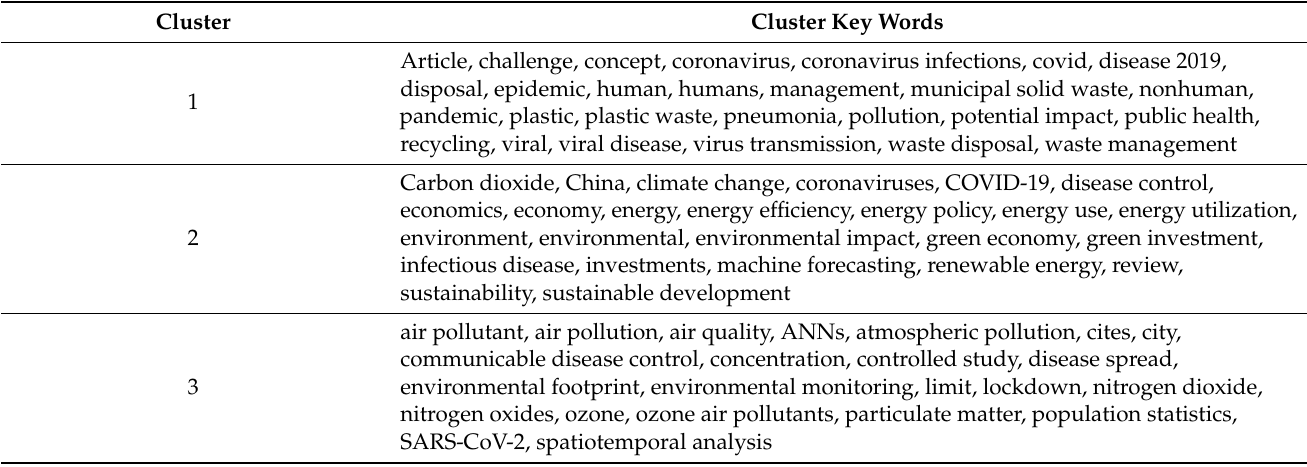
Table A2. The clusters for the top 10 publications within energy (subject area renewable energy, sustainability and the environment),